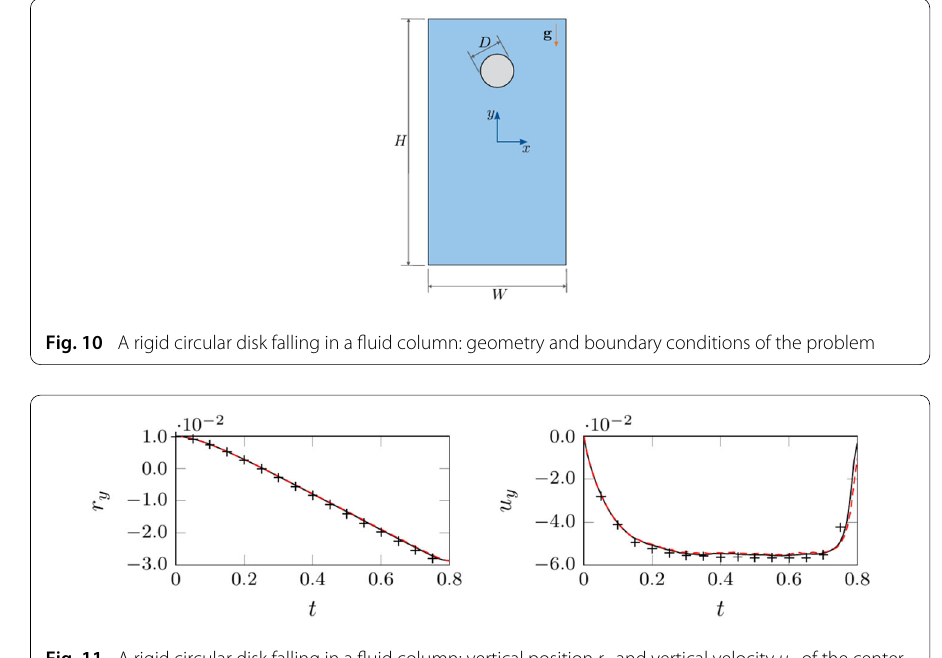
Fig. 11 A rigid circular disk falling in a fluid column: vertical position r y and vertical velocity u y of the center of the circular disk in the fluid column computed with the proposed formulation and an initial particle spacing of (cid:10) x = 2 . 0 × 10 − 4 (red dashed line) and (cid:10) x = 1 . 0 × 10 − 4 (black solid line) compared to the reference solution [8]